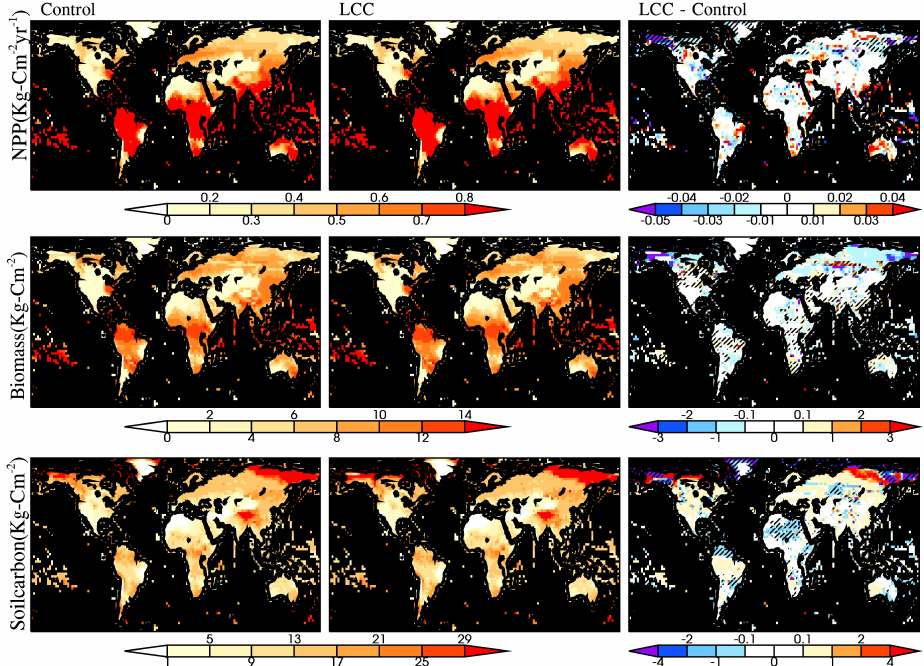
Fig. 5. Comparison between LCC and control simulations for terrestrial biosphere variables. The first and second column panels represent last 100-year mean from the control and LCC simulations, respectively. The third column panels represent the difference between LCC and the control simulations. Hatched areas are regions where changes are statistically significant at the 95% confidence level. Significance level is estimated using a Student-t test with a sample of 100 means and standard error corrected for serial correlation (Zwiers and von Storch,